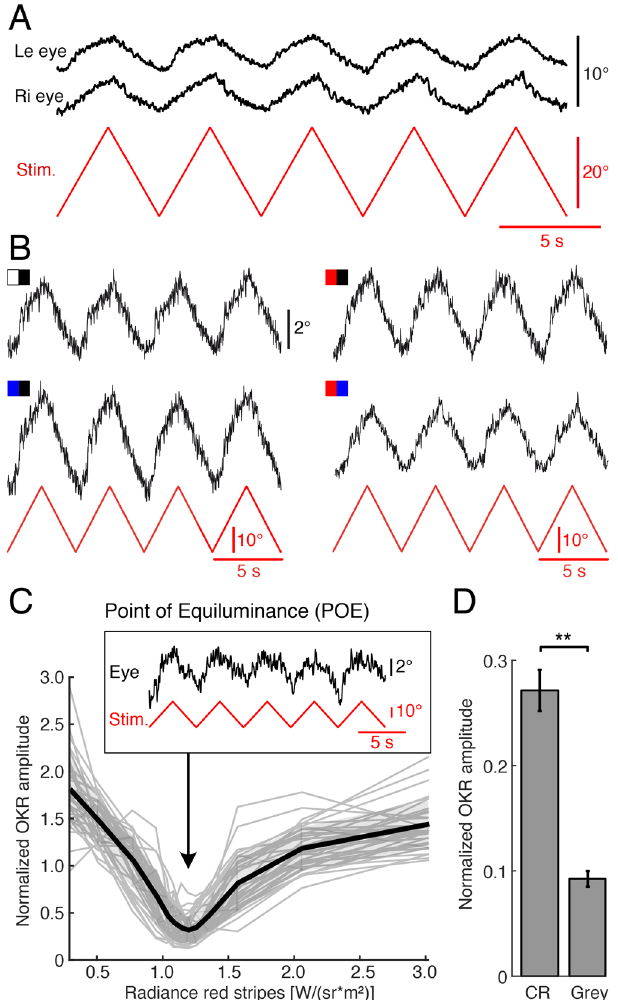
alternating motion of a black–white, black–blue, black–red and red–blue vertical striped pattern (see color- code) at constant velocity (± 10°/s; red traces). (C) Individual (grey traces) and averaged (black trace; n = 34) normalized OKR amplitudes evoked by a red-blue vertical striped motion pattern as function of the radiance of the red stripes; the inset illustrates a typical example of residual eye movements at the POE. (D) Bar plot depicting the response amplitude evoked by chromatic stimuli (CR) at the POE, determined individually for each animal, and control baseline amplitude (Grey). **, p < 0.01 (paired t-test) . Figure assembled with Affinity Designer (version